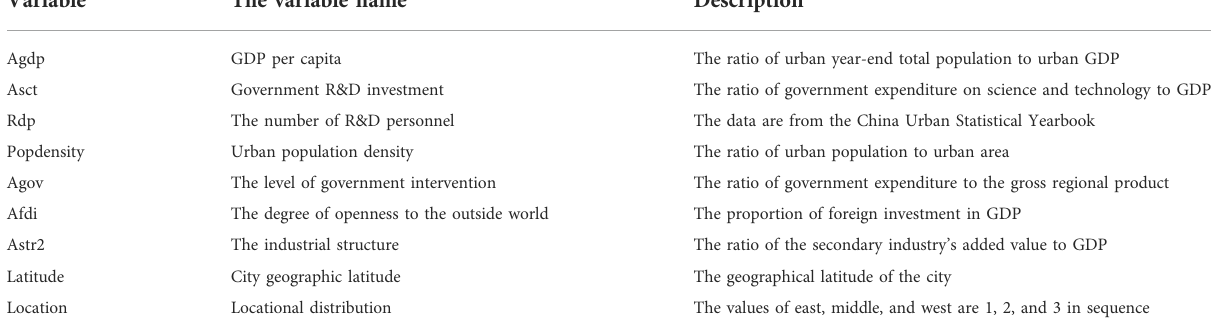
TABLE 4 List of control variables and